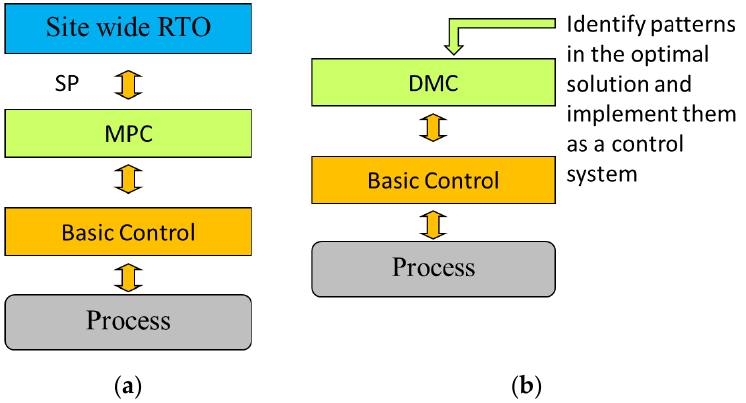
Figure 5. ( a ): traditional RTO/MPC implementation; ( b ): implementing patterns of the optimal solution by means of the DMC software.